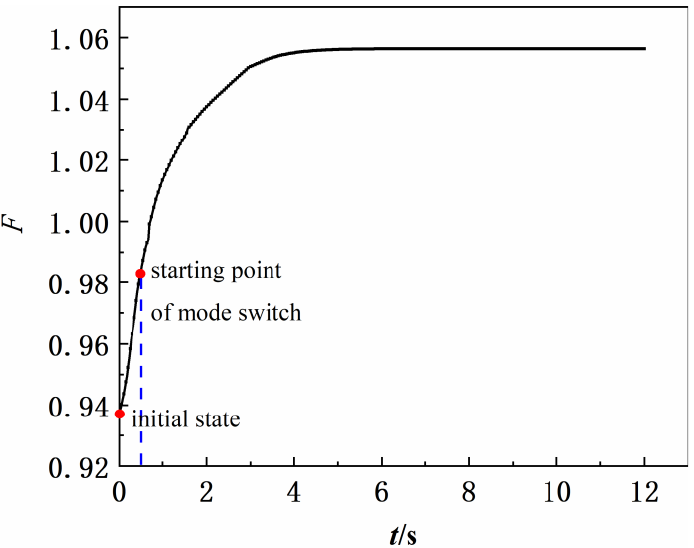
Figure 14. Change curve of thrust of working-mode switching from single bypass to double bypass at H = 0 km, Ma = 0.